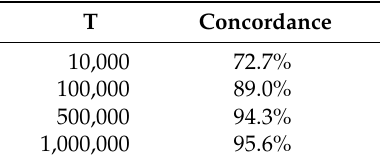
Table 1. The list of concordance following different